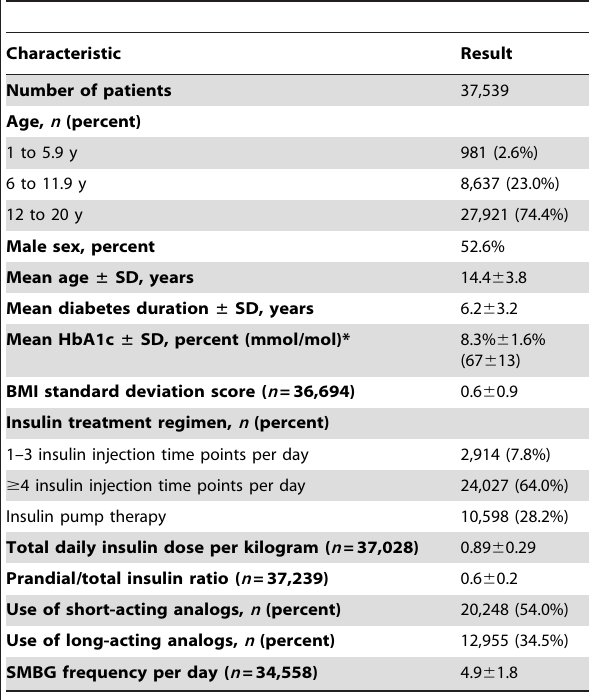
Table 1. Characteristics of patients with type 1 diabetes treated between 1995 and